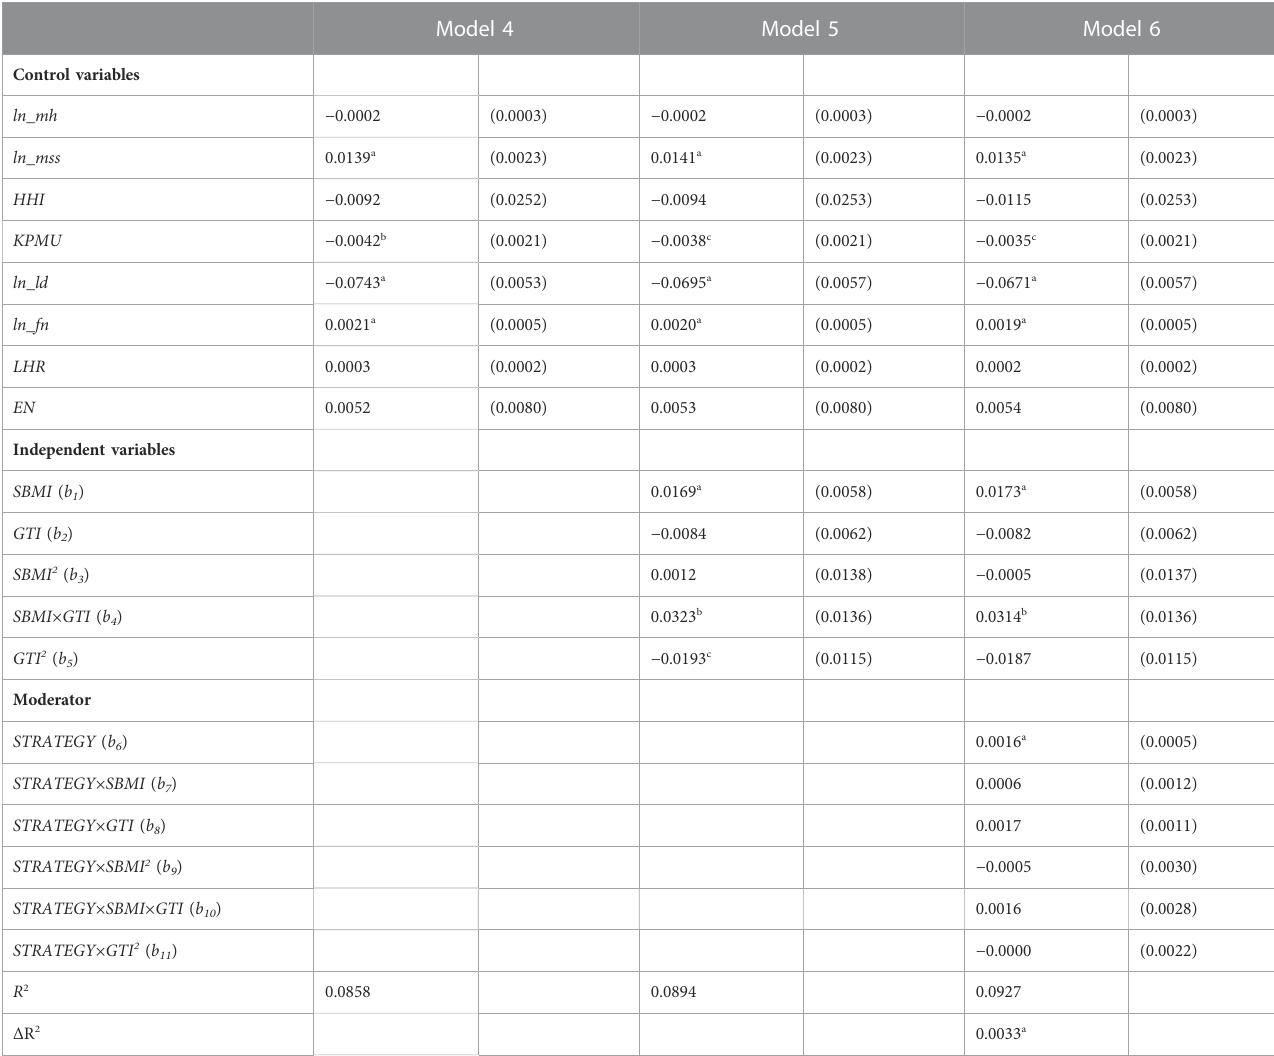
TABLE 4 Moderation effects of degree of corporate strategic